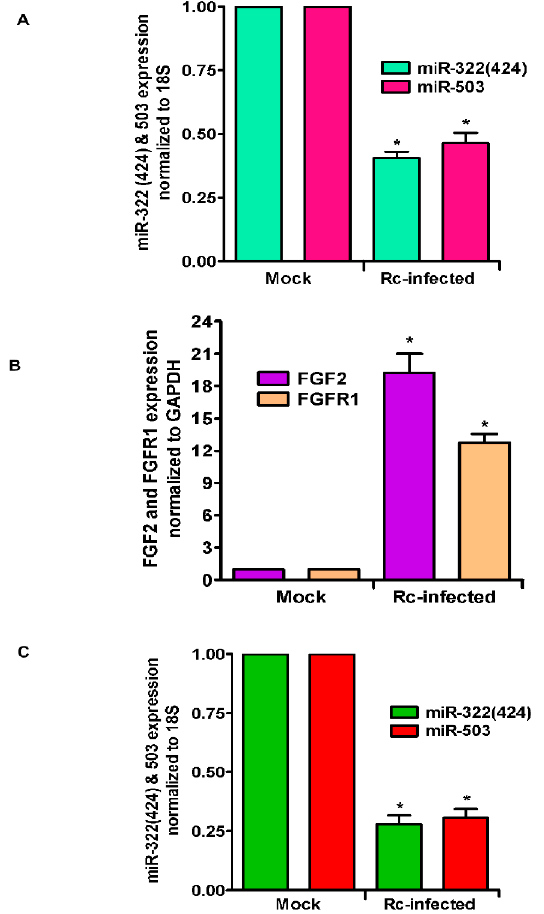
Figure 3. Expression of miR-424(322), miR-503, and FGF2/FGFR1 in R. conorii -infected C3H/HeN mice in vivo. Mice were infected with R. conorii (2.25 × 10 5 pfu) intravenously (IV). Control animals received IV injection of saline. On day 3 post-infection, mice were anesthetized, blood and lungs were collected, RNA was isolated, and expression of both miRNAs in the lungs ( A ) and blood ( C ) and FGF2/FGFR1 in the lungs ( B ) was measured by qRT-PCR. The asterisks indicate statistically significant change ( p ≤ 0.01).